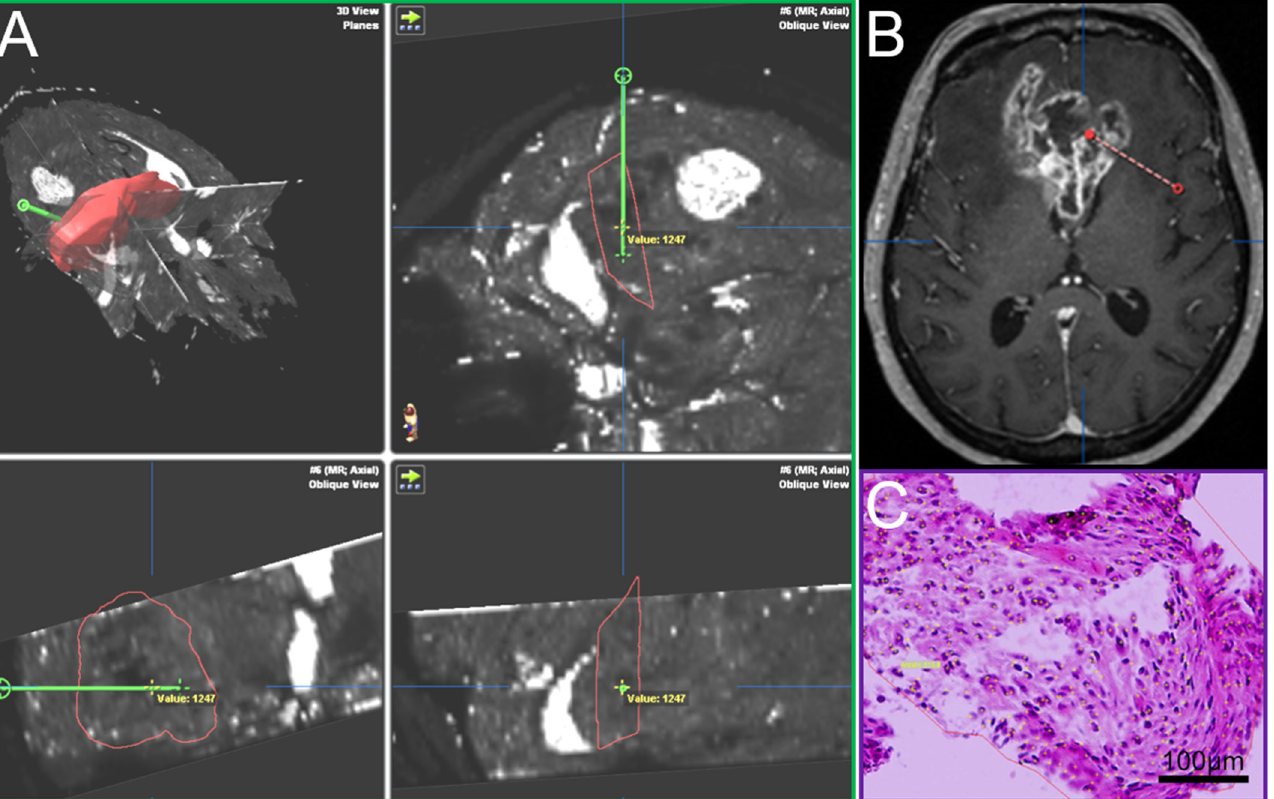
Figure 1. ( A ) T2 ′ maps with trajectory (green, iPlan BrainLab), ( B ) Conventional MRI, contrast-enhanced T1, axial plane, with trajectory (red), ( C ) Hematoxylin-eosin stain of a biopsy sample.